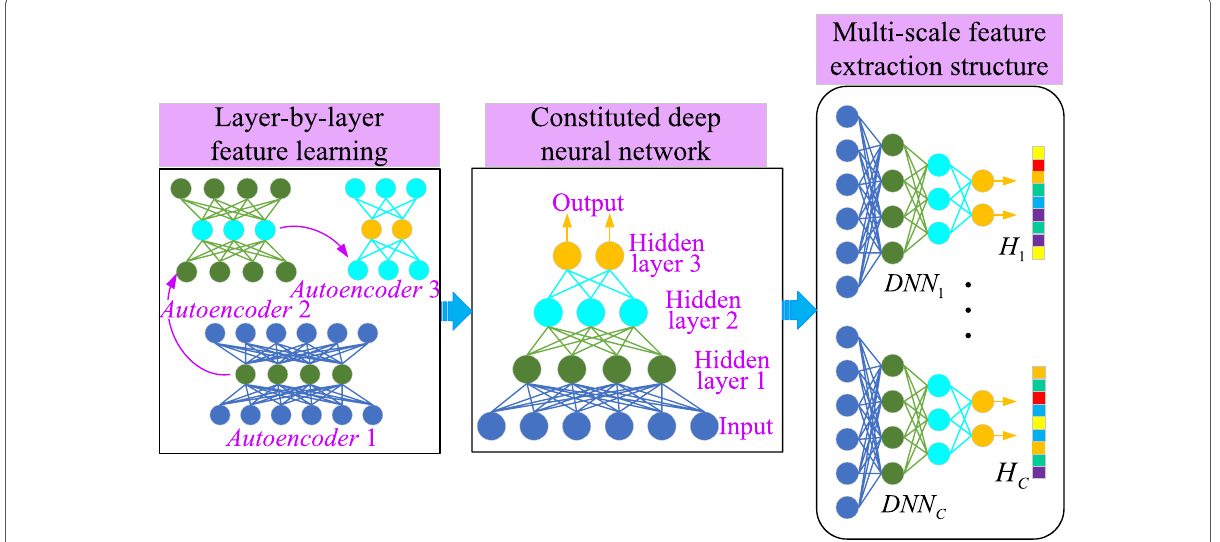
Figure 3 Feature extraction structure of multi-scale deep neural